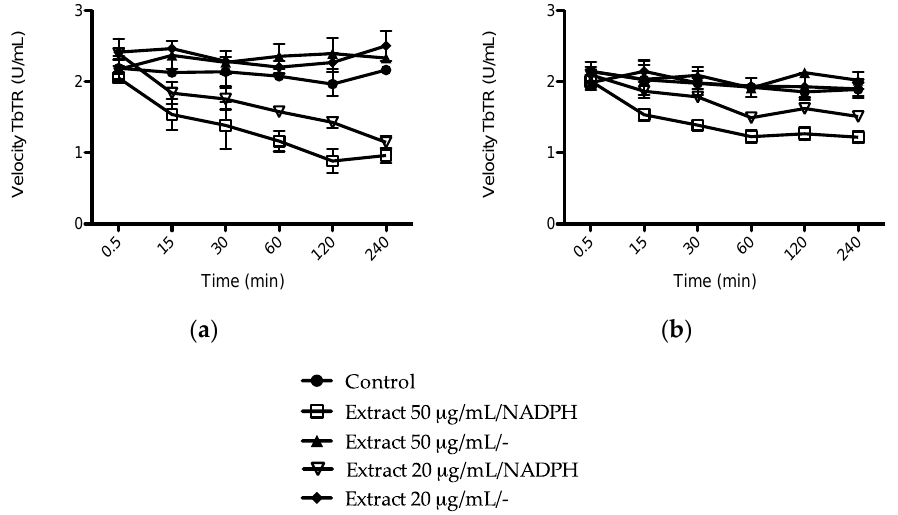
Figure 7. Irreversible inhibition of Trypanosoma brucei trypanothione reductase (TbTR) flavoenzyme by 50 and 20 μg/mL of ( a ) Allium sativum and ( b ) Allium cepa extracts. Data are shown as mean of three independent experiments ± SD.